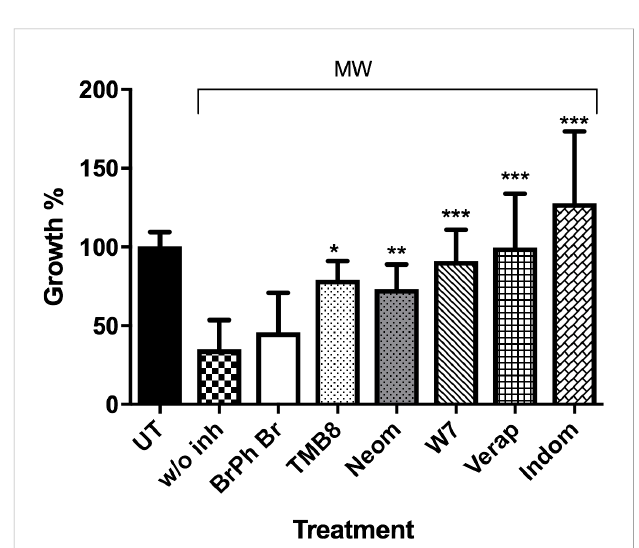
FIGURE 8 Ca 2+ signaling proteins involved in MW-induced death. uRBCs or iRBCs were incubated 1 h before MW in WG with or without inhibitors of Ca 2+ transduction pathways, and their growth assessed by fl ow cytometry (Bars from left to right: Untreated, bromophenyl bromide, TMB8, neomicin, W7, verapamil, and indomethacine). All bars represent means ± SEM of duplicates. n=2, unpaired, one-way ANOVA (Bonferroni ’ s multiple comparison). *p<0.05,**p<0.01,